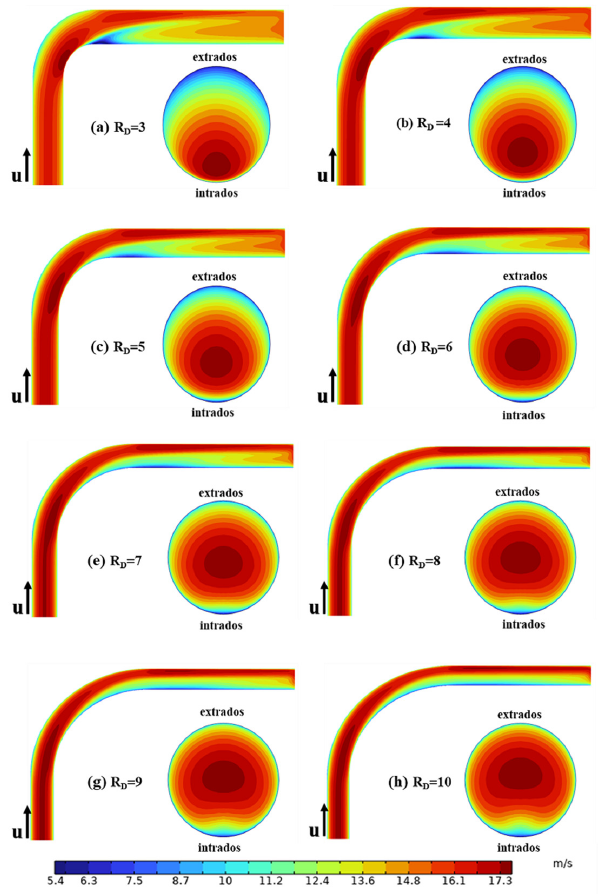
Figure 14. Average fluid velocity and contour fill plots for different curvature ratio pipe cross sections and elbow 45 axial sections.